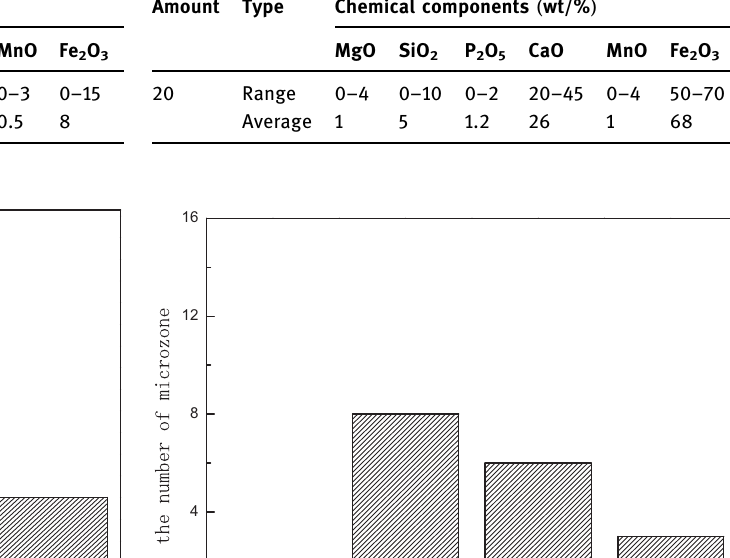
Table 3: Composition of phase A Amount Type